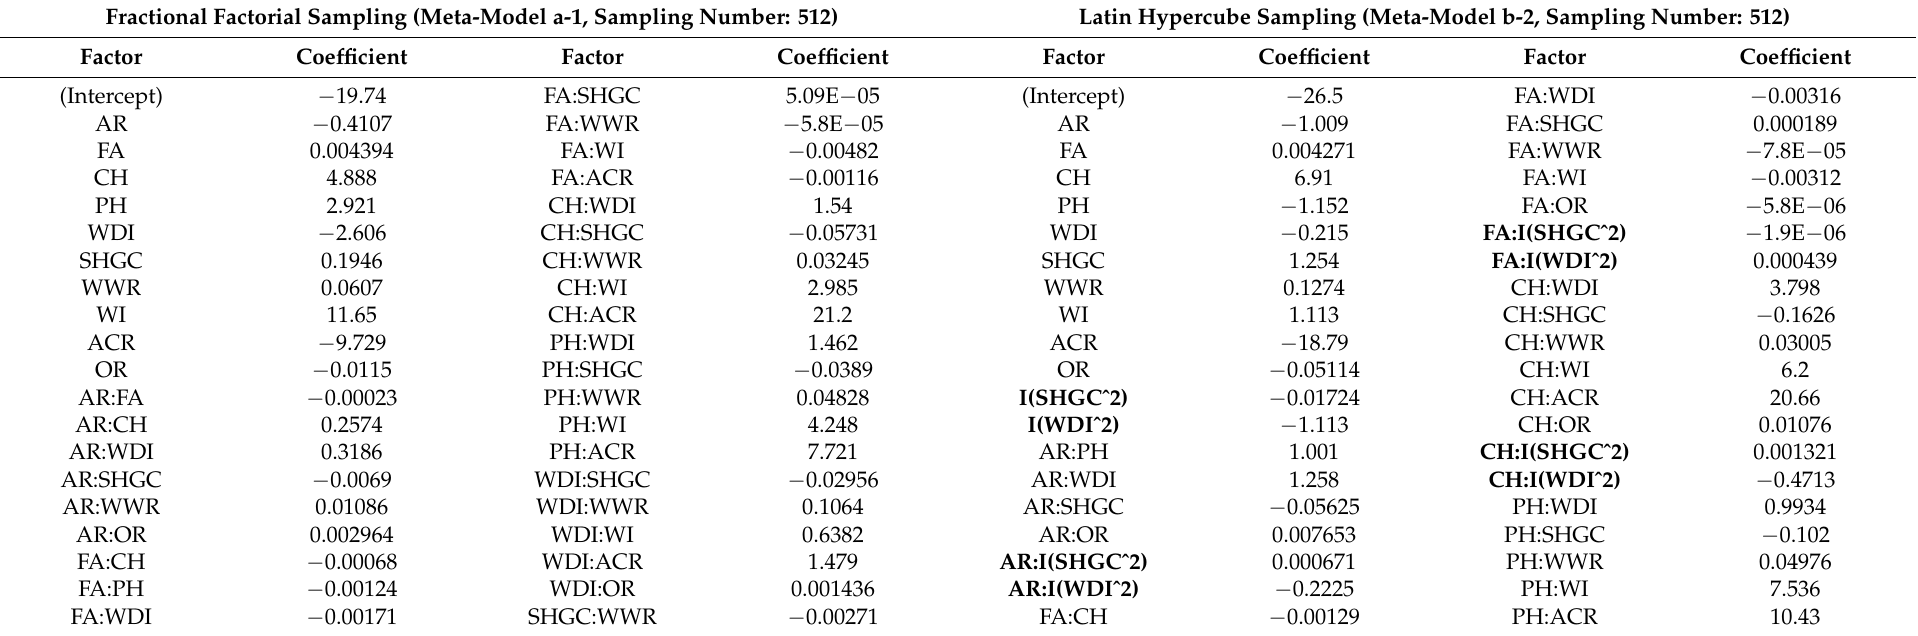
Table A1. List of the main effect and interaction terms and coefficients of Equation (1) for the heating load of the building. Fractional Factorial Sampling (Meta-Model a-1, Sampling Number: